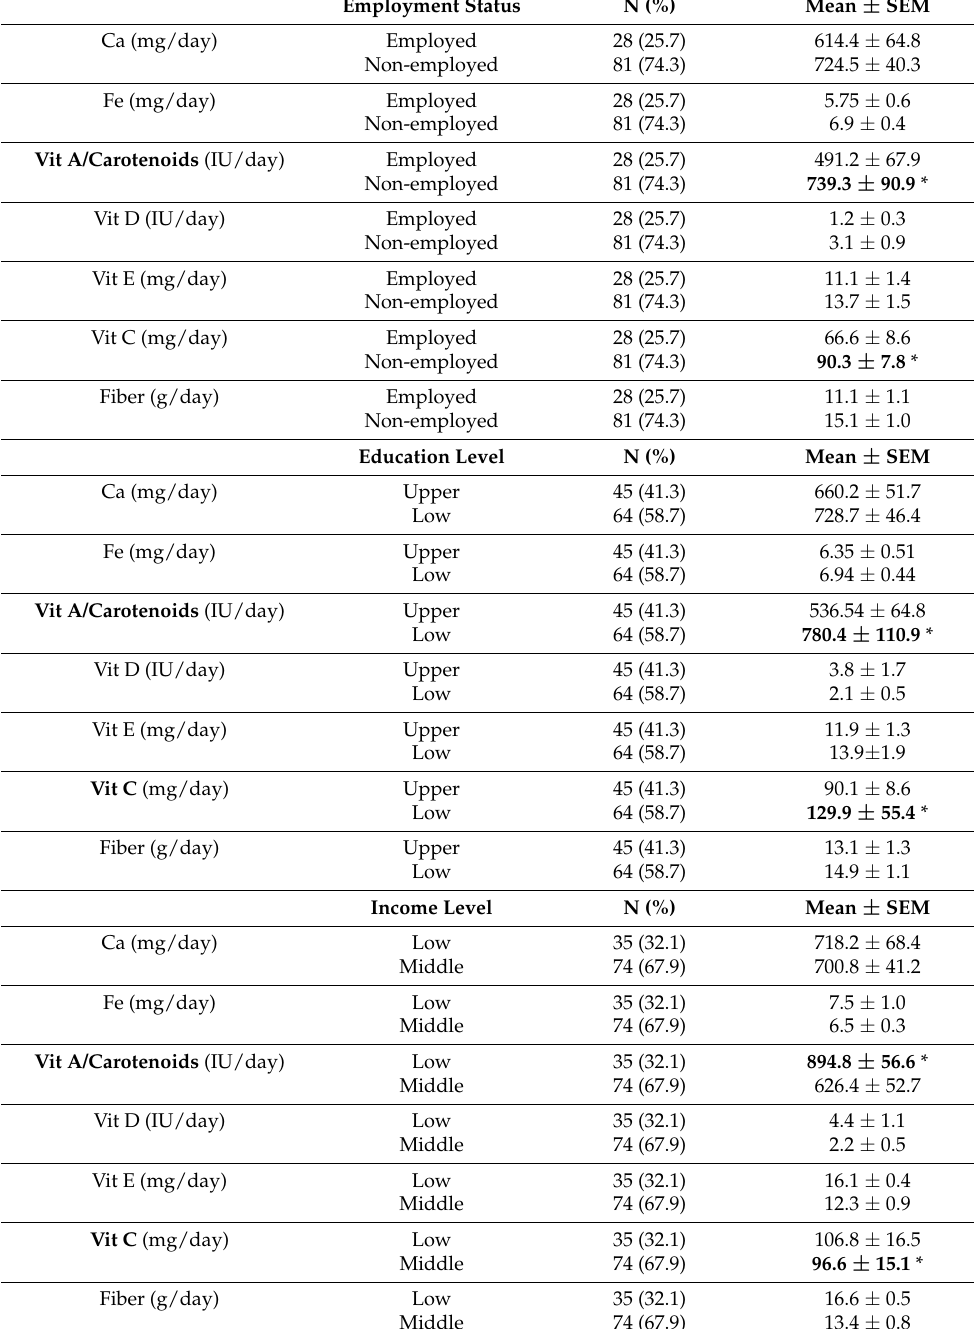
Table 3. Association of maternal employment status, education and income levels and dietary intake of minerals, vitamins and fiber of